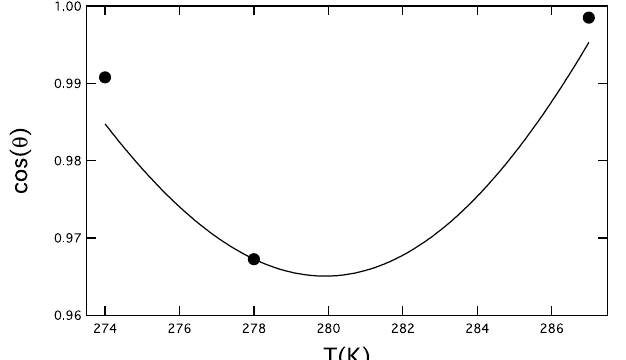
Figure 5. Markers: directly determined values of cos θ at the three temperatures as taken from the contact angles given in Table 3. Smooth curve: result of integrating Equation